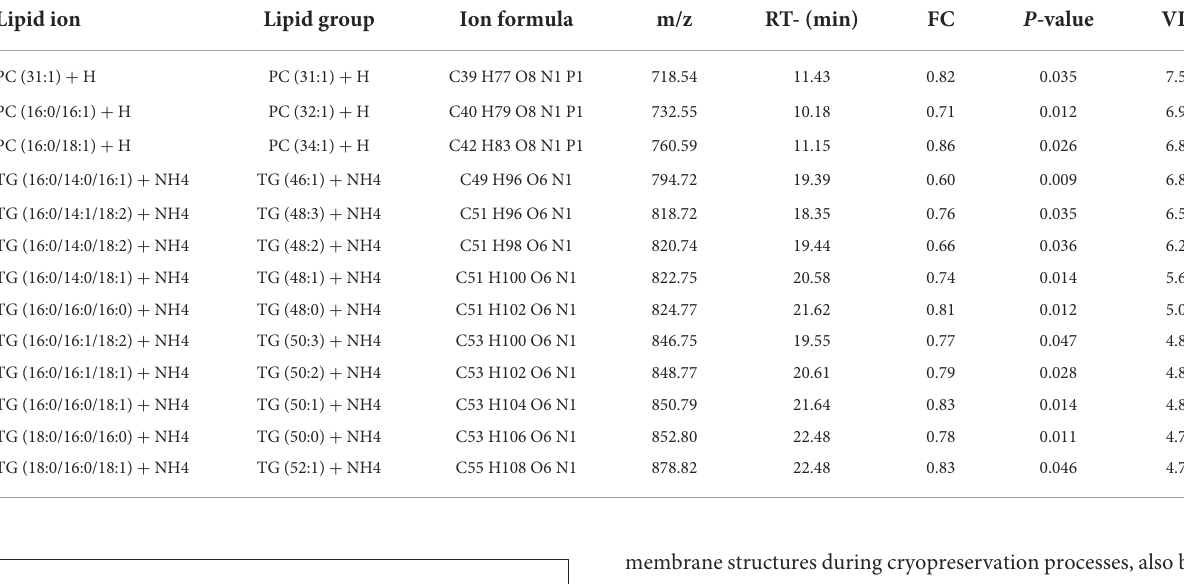
TABLE 3 The differential lipid species in high and low freezability sperm. Lipid ion Lipid group Ion formula